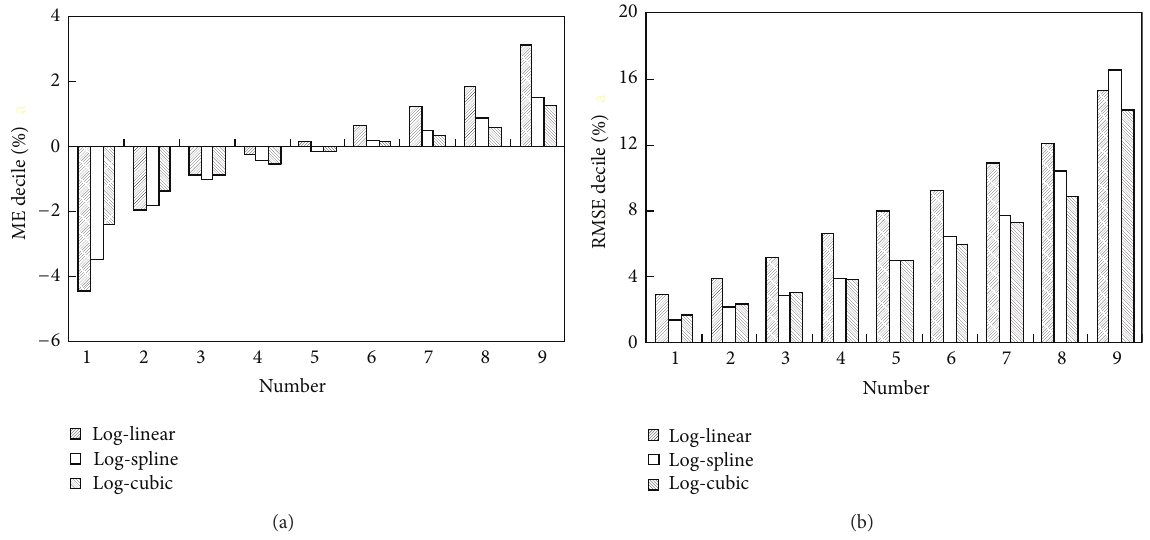
Figure 2: ME (a) and RMSE (b) deciles of the log-linear, log-spline, and log-cubic